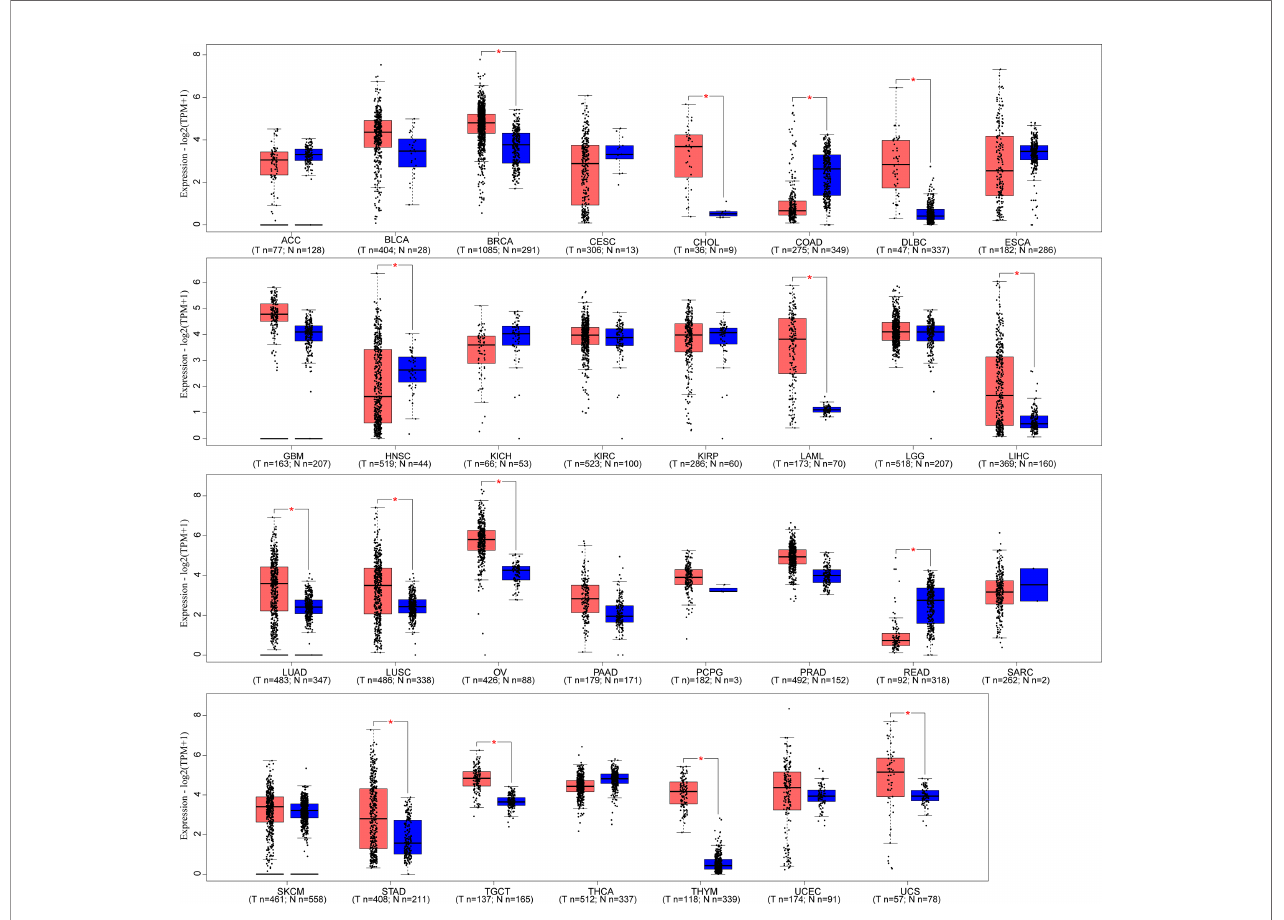
FIGURE 3 | LINC00665 expression in human cancers and corresponding normal tissues (data from TCGA and GTEx). * p <